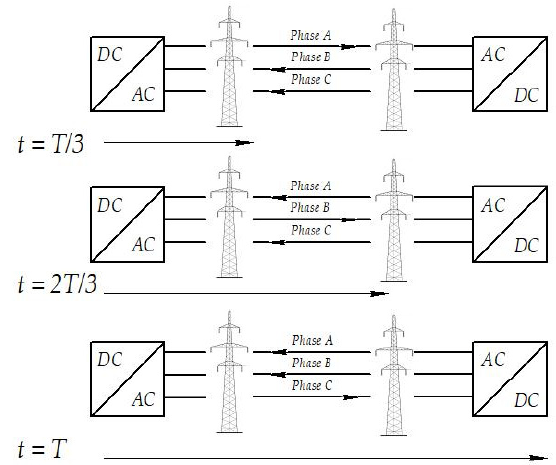
Figure 1. Operating state of the conductors according to the proposed method; T represents the switching